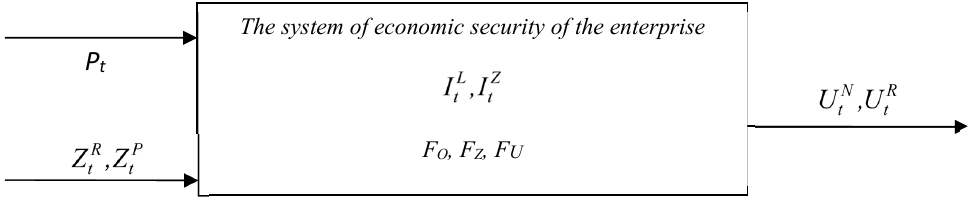
Fig. 1. Fundamental model of the economic security system of the